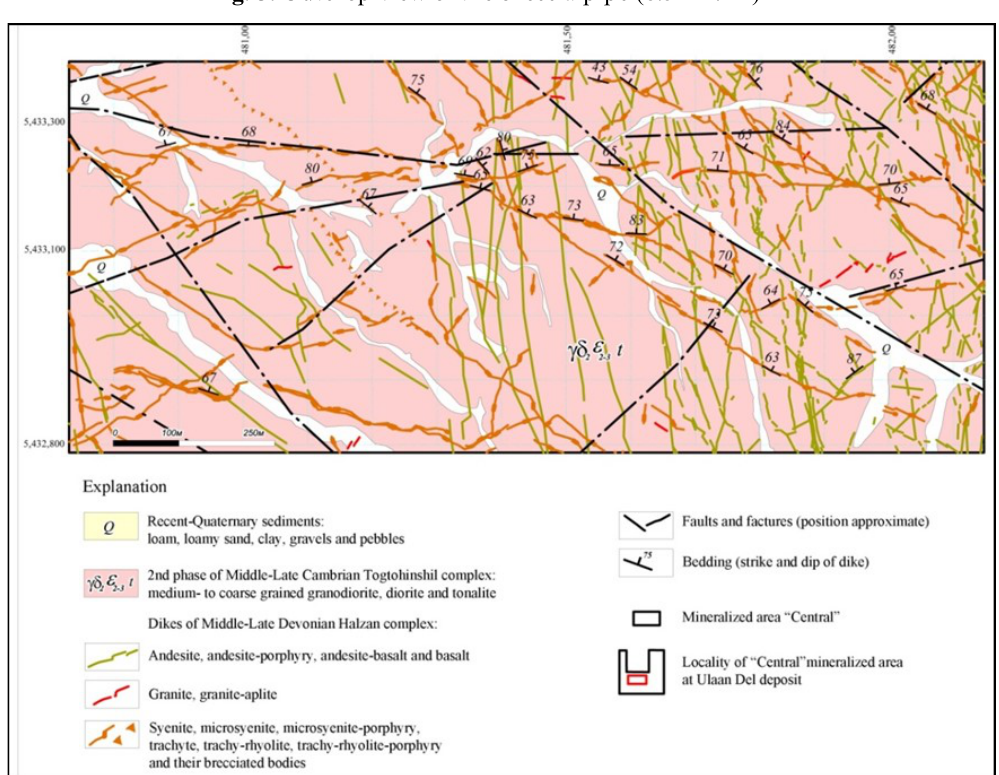
Fig. 4. Geological map of the Central area of the Ulaan Del